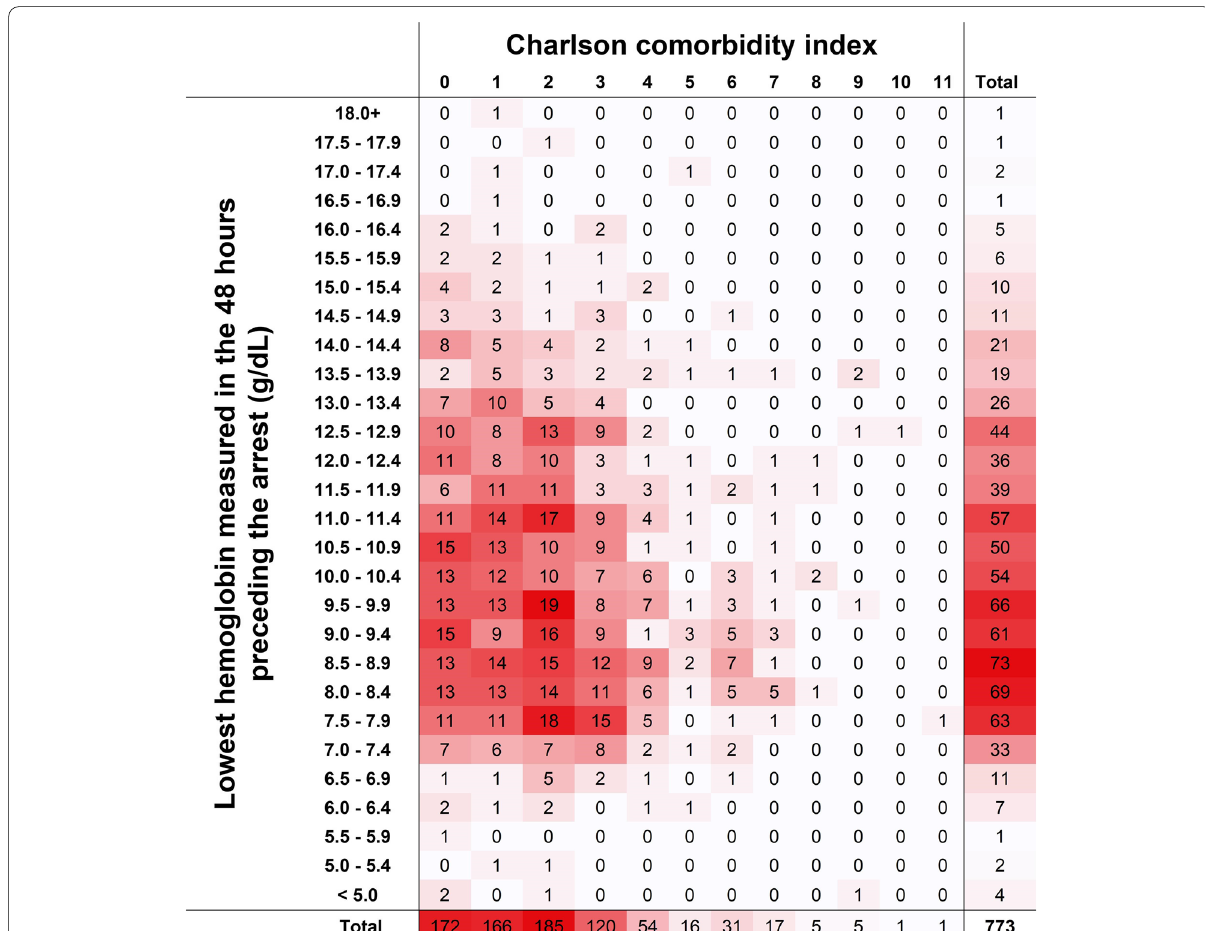
CCI Charlson comorbidity index, SD standard deviation, IQR interquartile range Missing data–adrenaline—43 (5.6%)